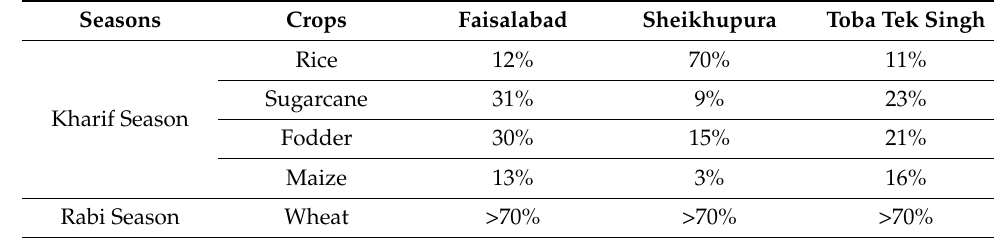
Table 3. Summary of the highest growing crop in highly stressed areas in Rabi and Kharif